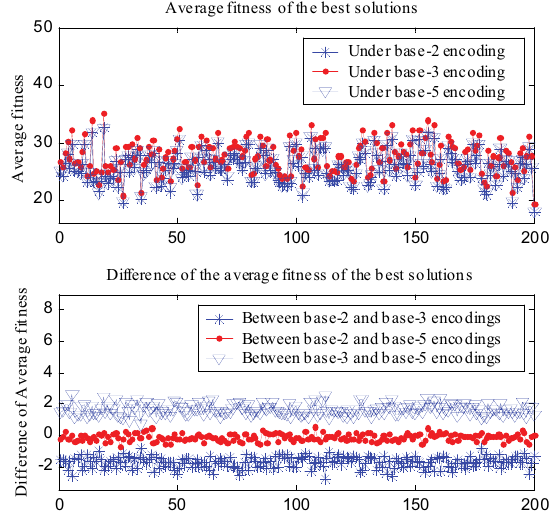
Fig. 4. The average fitness of the best solutions found in the 20 rounds of calculation for the fitness functions ( a i sin ( 2 π 3 i − 1 x + ϕ i )+ | a i | ) under the three encod- ∑ 32 i = 1 ings.The GA with the base-3 encoding significantly outperform the other GAs.